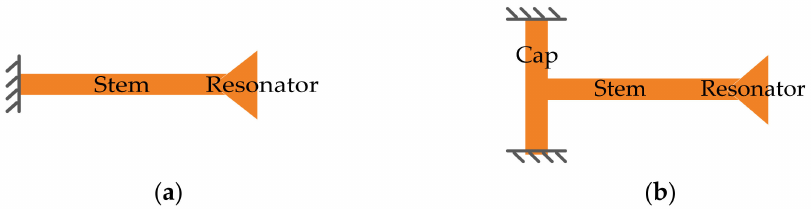
Figure 4. Schematic diagrams of suspensions. ( a ) Straight-beam suspension; ( b ) T-shaped suspension. Adapted with permission from Ref. [26].